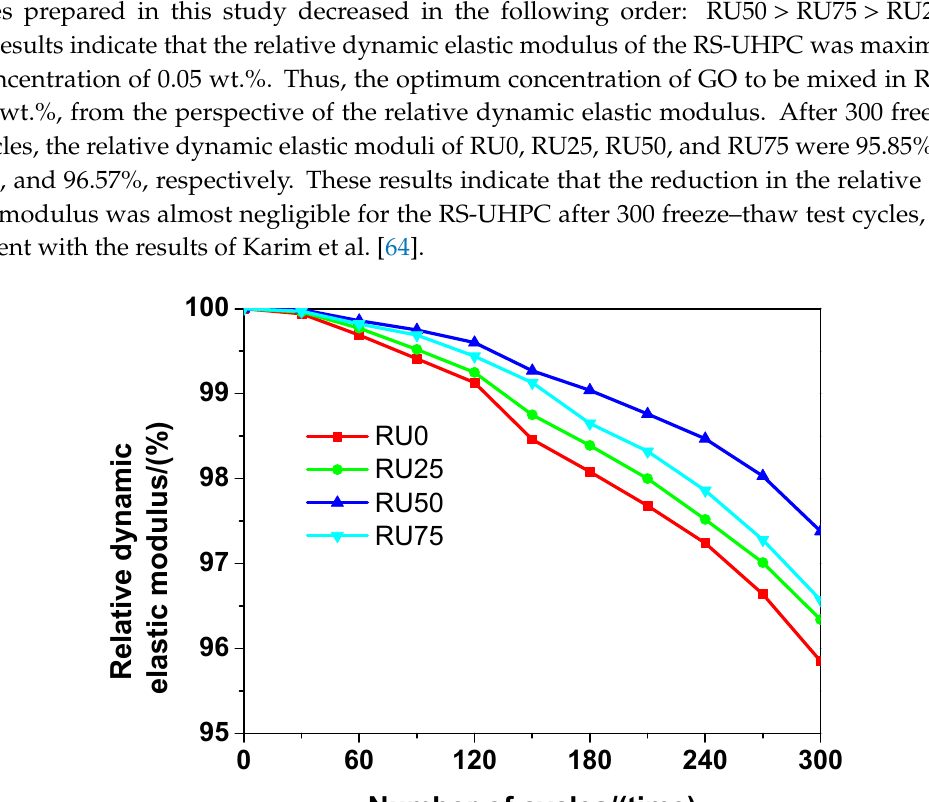
Figure 11. The relative dynamic elastic modulus of RS-UHPC with different contents of GO.